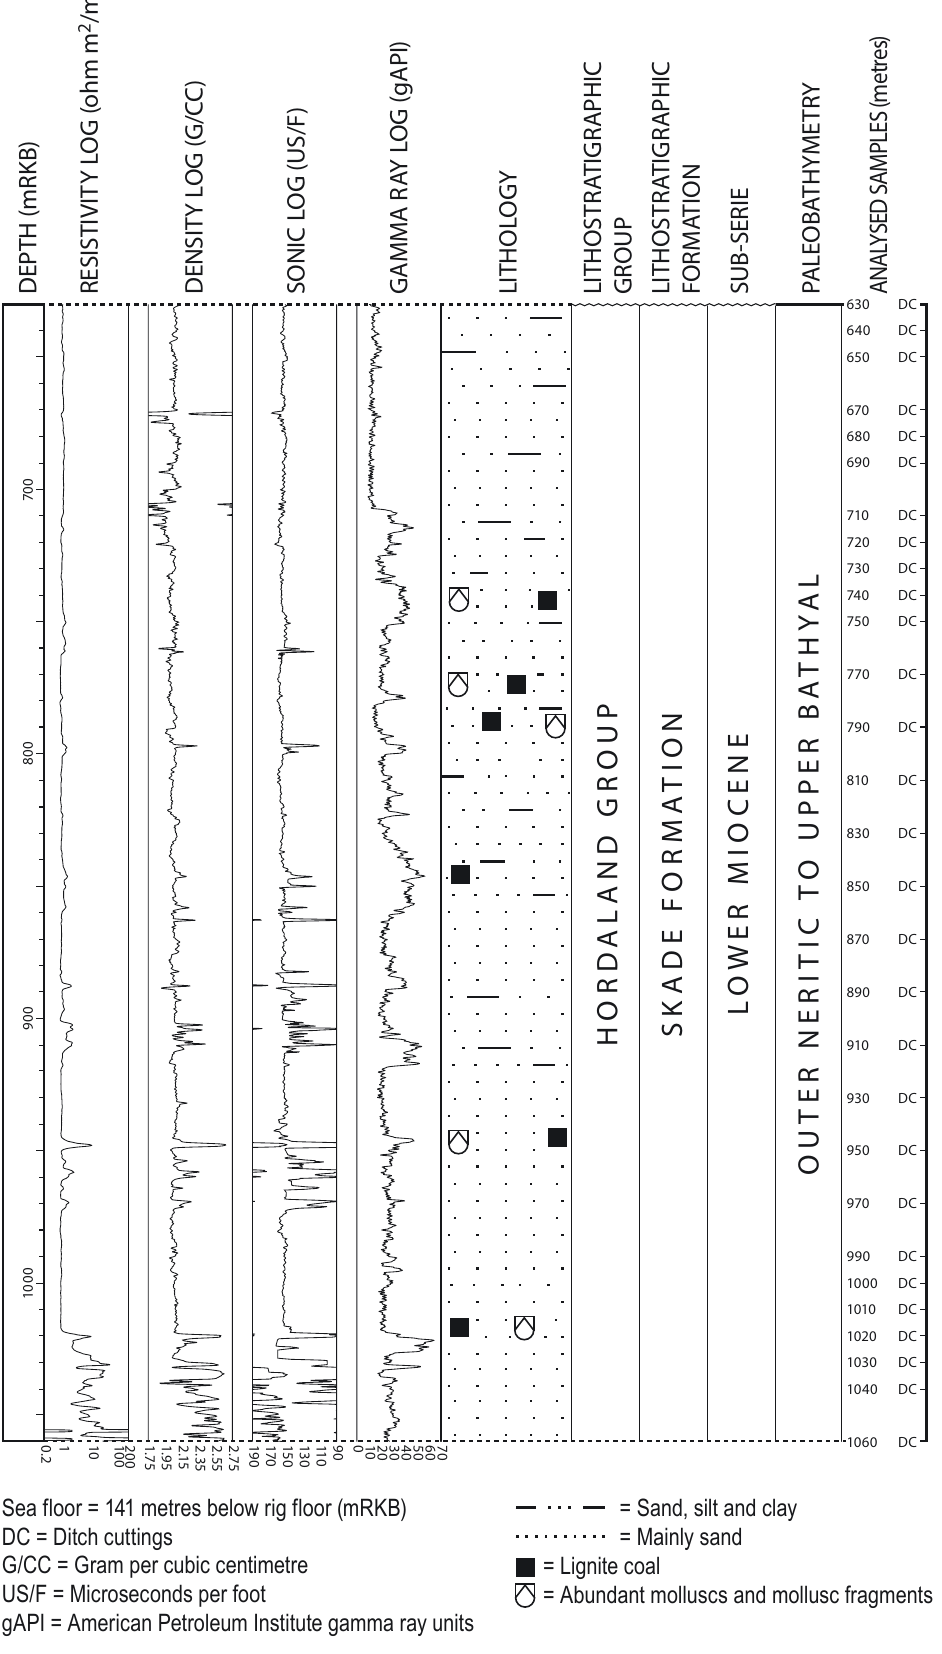
Figure 50. Well summary figure including resistivity log, density log, sonic log, gamma-ray log, lithology, litho- stratigraphic units, sub-series, paleobathymetry and analysed samples for the middle part of the investigated sequence in well 25/2–10 S (lower Miocene; modified after Eidvin et al.,